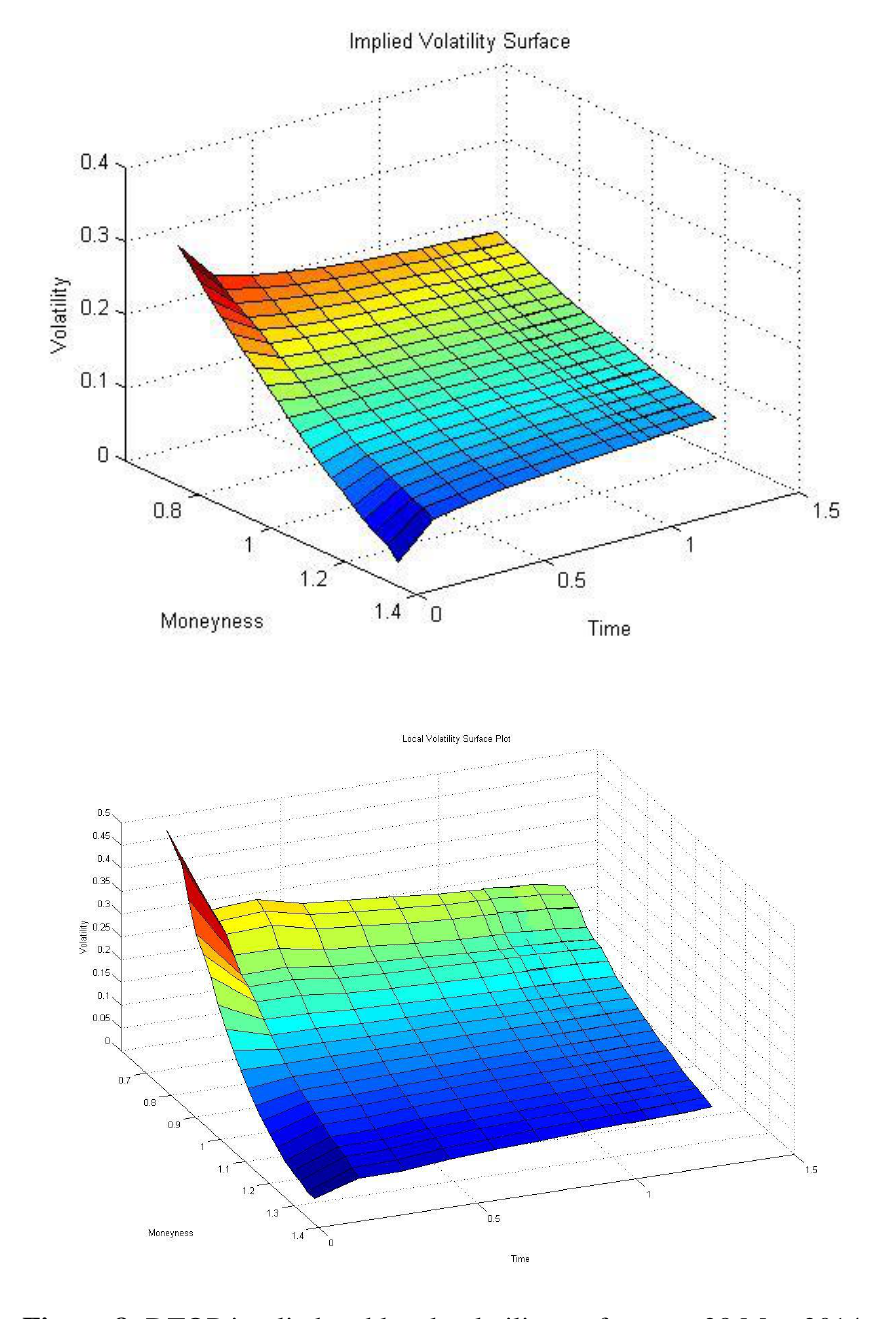
Figure 8. DTOP implied and local volatility surfaces on 28 May